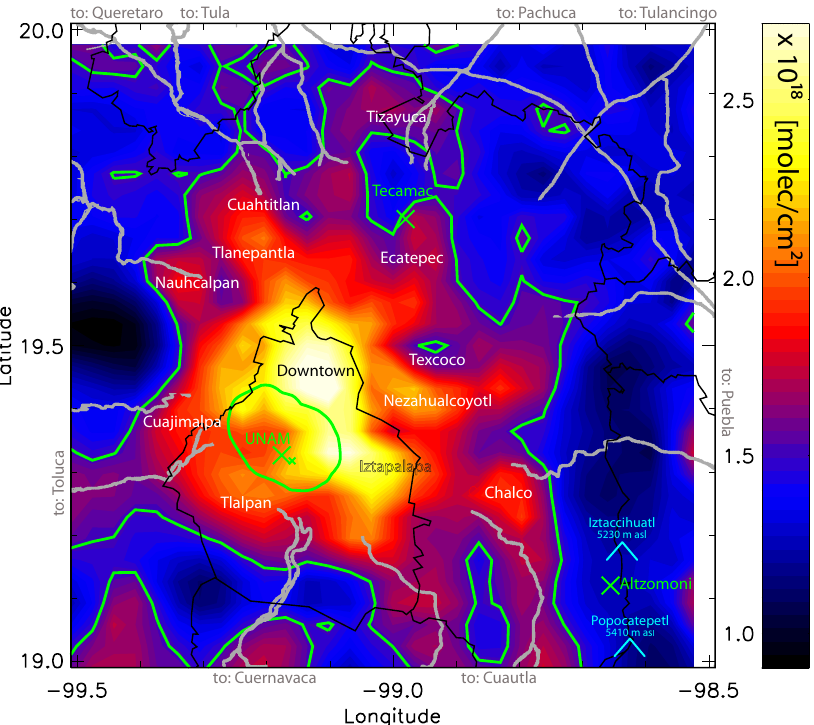
Fig. 6. Average CO column distribution for the morning overpass of MetOp-A in the Mexico basin reconstructed from the IASI data between 2007–2010. The locations of the ground based measurements are indicated by the large green crosses. The NCAR measurements during the MILAGRO campaign (March 2006) were taken at the university of Tecamac and the UNAM-measurements (2007–2009) at the UNAM Campus. The inner green contour-line is drawn around UNAM and indicates the area which contains 95% of the CO amount measured later around noon at UNAM. The outer green contour-line indicates the 1 . 51 × 10 18 moleccm − 2 level and defines the Mexico City Metropolitan Area (MCMA) in this work. (A small cross near UNAM, indicates where the line of sight between the UNAM-instrument and the sun passes through the upper part of the boundary layer during the morning overpass of IASI and illustrates that inhomogeneity might affect the conversion from slant to vertical